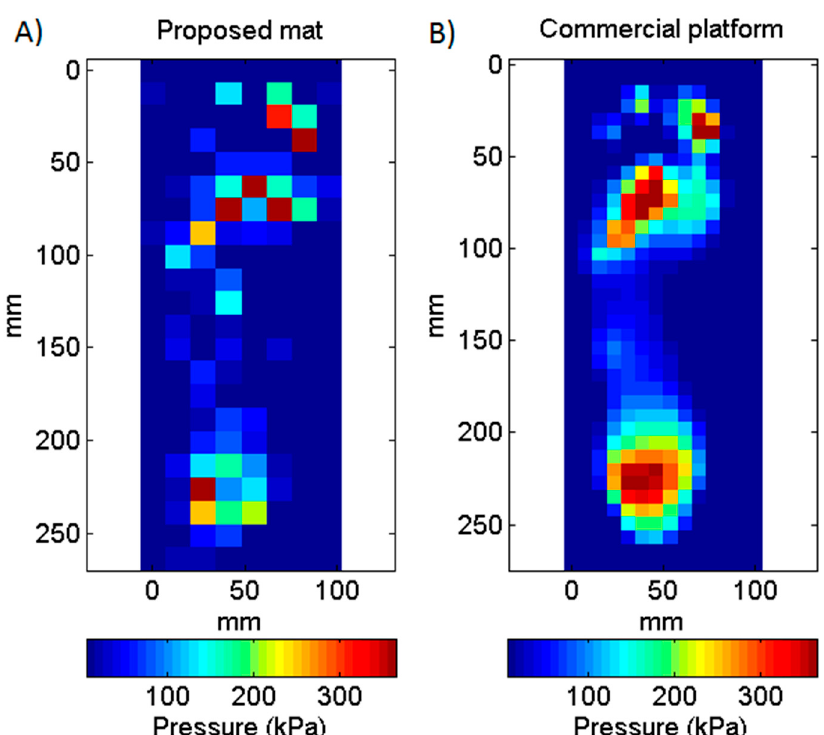
Figure 11. Comparison between two maximum plantar pressure maps obtained with the proposed mat ( A ) and the commercial platform ( B ) during a walking trial. Maps represent the maximum pressure recorded during a single step.